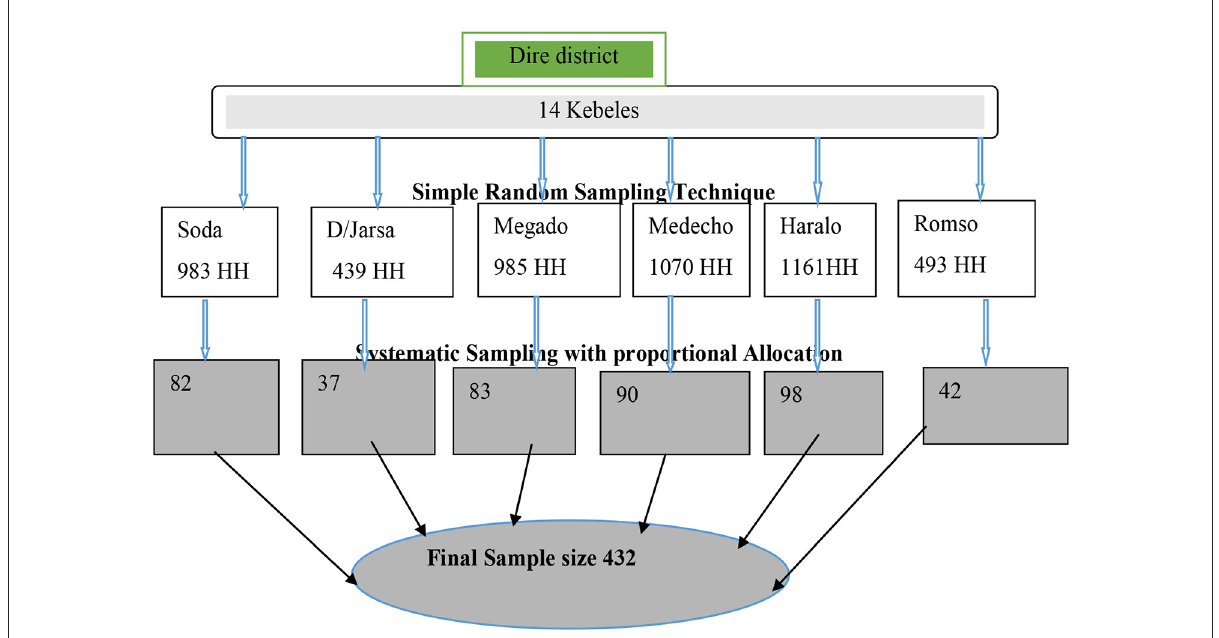
FIGURE2 Schematic presentation of sampling